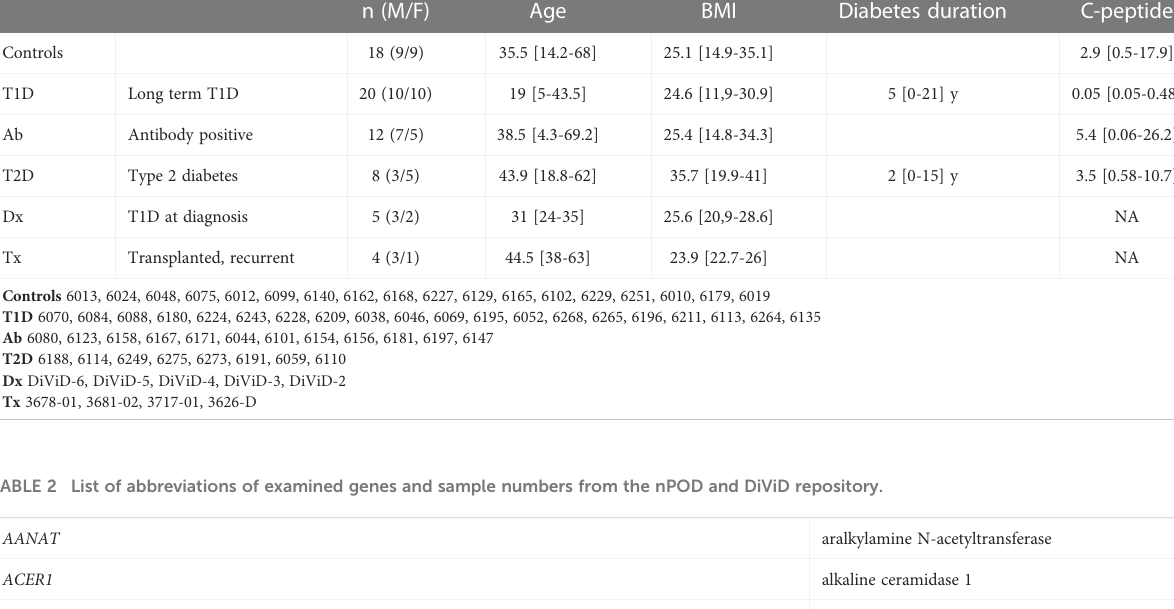
alkaline ceramidase